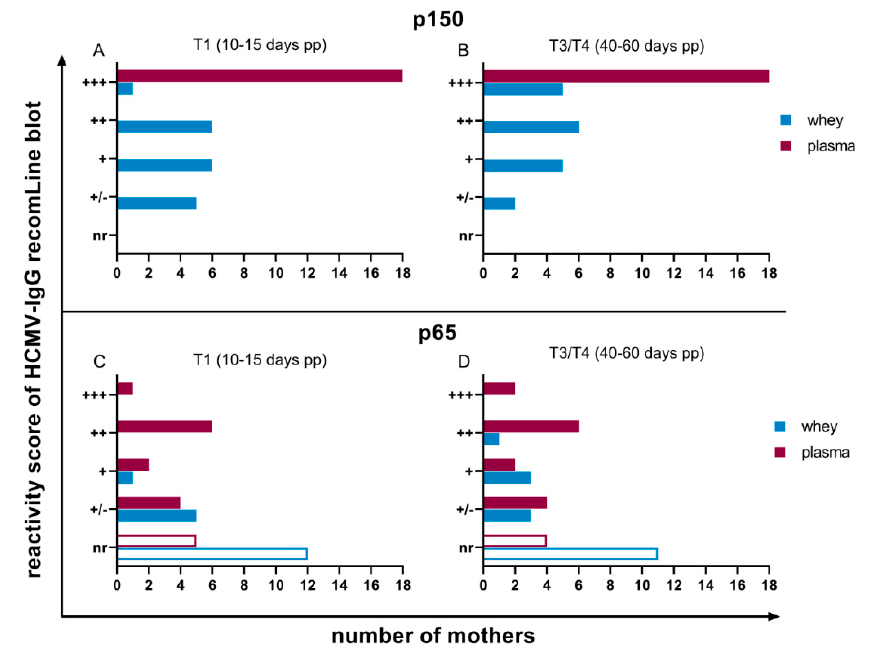
Figure 4. Reactivity scores of IgG recomLine blots for anti-rec150-IgG at ( A ) T1 (10 to 15 days pp) and ( B ) T3/T4 (40 to 60 days pp) and anti-recp65-IgG at ( C ) T1 (10 to 15 days pp) and ( D ) T3/T4 (40 to 60 days pp). Scoring of antibody reactivity as in Figure 3.